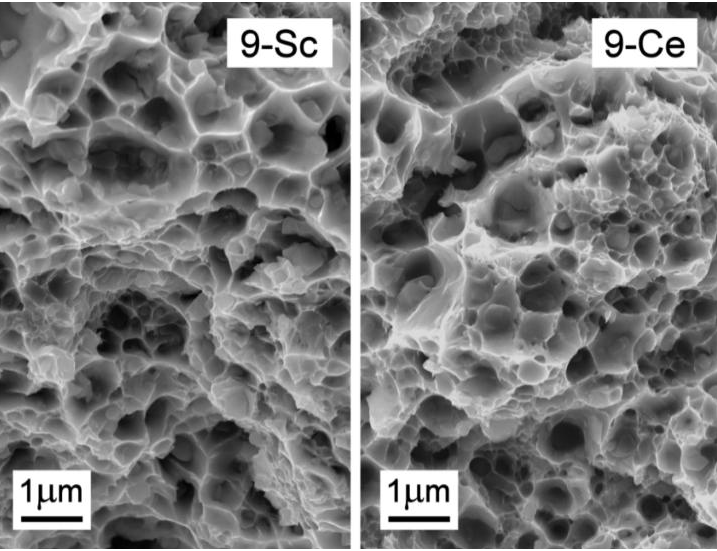
Figure 5. Detailed micrographs of the fracture surface of 9-Sc and 9-Ce ODS steel tested at room temperature, documented by SEM.